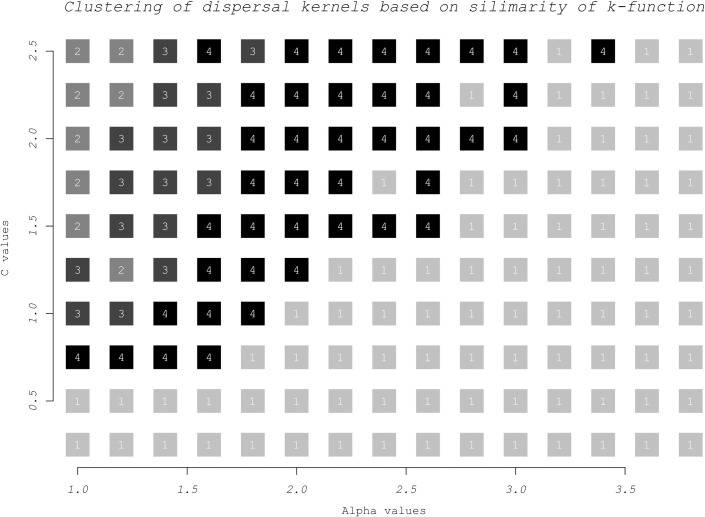
Kernel clusters.How different values of α and C cluster in four groups. x axis clipped at 4; α>4 clusters in group 1.